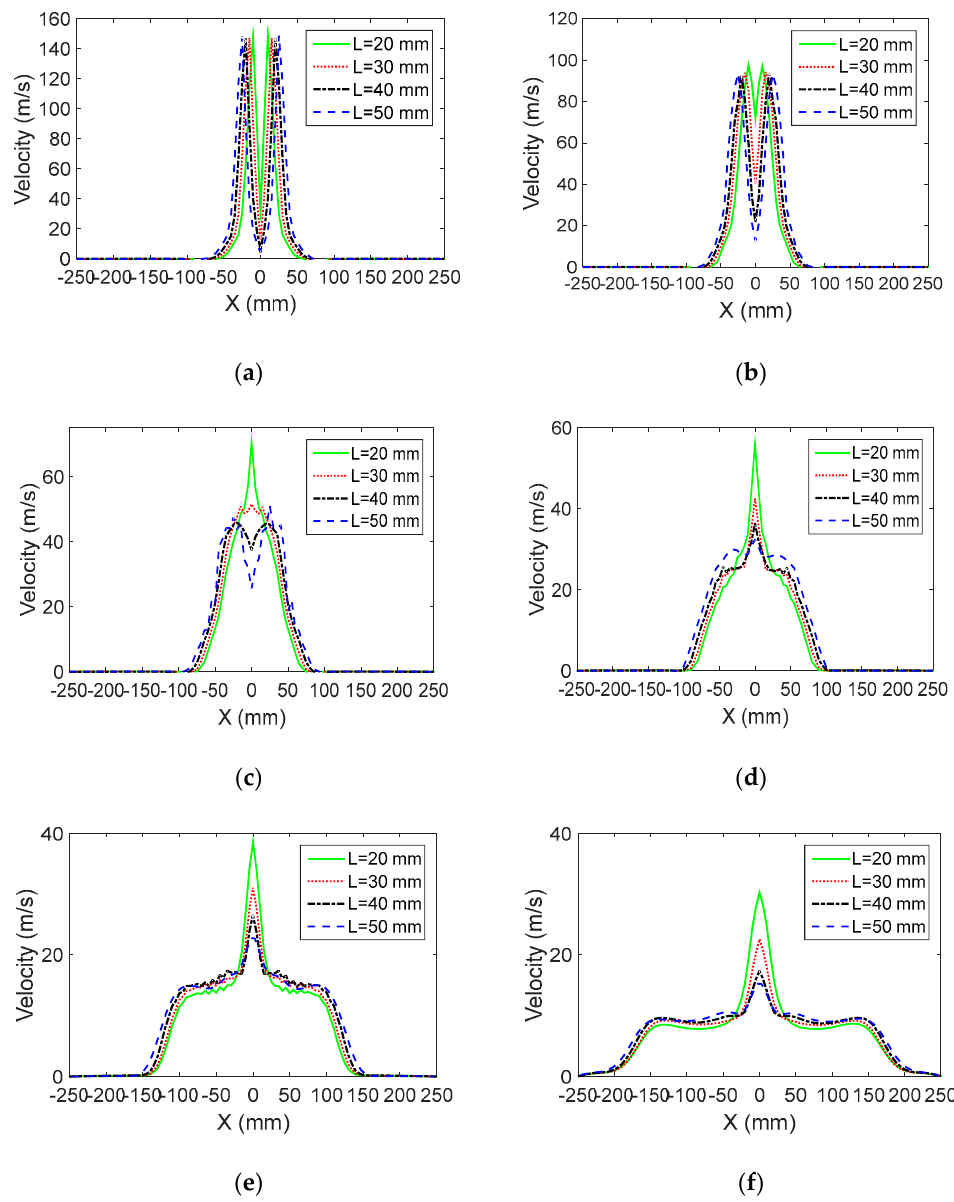
Figure 6. Velocity profiles along the y -axis direction for each cross-section: ( a ) y = 15 mm; ( b ) y = 25 mm; ( c ) y = 35 mm; ( d ) y = 50 mm; ( e ) y = 100 mm; ( f ) y = 170 mm. ( c ) y = 35 mm; ( d ) y = 50 mm; ( e ) y = 100 mm; ( f ) y = 170